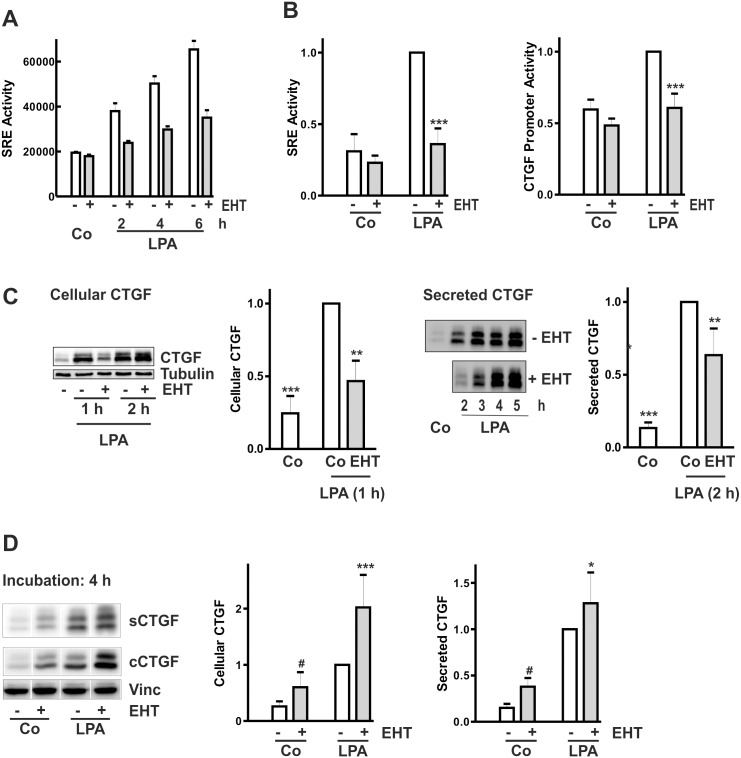
Time-dependent effects of Rac1 inhibition by EHT1864 on CTGF regulation.(A) HKC-8 cells were transfected with SRE promoter constructs. After pre-incubation with EHT1864 (10 μM) for 30 min, the cells were stimulated with LPA (10 μM) for the times indicated. Data are means ± SD from one experiment with triplicate transfections. (B) HKC-8 cells were transfected with SRE or 4.5 kb CTGF promoter constructs. Relative luciferase activity was determined in control cells and cells pre-treated with EHT1864 (10 μM) for 30 min and then stimulated with LPA (10 μM) for 3–4 h. Data are means ± SD of 7 (SRE) and 3 (CTGF promoter) experiments. Activity in LPA-stimulated cells was set to 1 in each experiment. *** p<0.001, compared to cells stimulated with LPA, ANOVA with Dunnett’s multiple comparison test. (C) HKC-8 cells were pre-incubated with EHT1864 (10 μM) for 30 min and then stimulated with LPA (10 μM) for the times indicated. Cellular CTGF was determined in preparations of cellular homogenates by Western blotting. Tubulin was used to control for equal blotting and detection. The graph summarizes data of n = 3 experiments, stimulated with LPA for 1 h (CTGF/tubulin, means ± SD). Secreted CTGF was determined in precipitates of cell culture supernatants by Western blotting. The graph summarizes data of n = 4 experiments, stimulated with LPA for 2 h. Data were normalized to LPA-stimulated CTGF synthesis. *** p<0.001, ** p<0.01, ANOVA with Tukey’s multiple comparison test. (D) HKC-8 cells were pre-incubated with EHT1864 (10 μM) for 30 min and then stimulated with LPA (10 μM) for 4 h. Secreted CTGF (sCTGF) was determined in precipitates of cell culture supernatants and cellular CTGF (cCTGF) in cellular homogenates by Western blotting. Vinculin (vinc) served as control. Samples were detected on one blot which had to be rearranged. Data of 4–5 experiments (cellular CTGF, 4 h) and 5–7 experiments (secreted CTGF, 4–6 h) are summarized in the graphs. CTGF expression in LPA-stimulated cells was set to 1 in each experiment. * p<0.05, ***p<0.001 compared to LPA-stimulated cells, ANOVA with Tukey’s multiple comparison test. # p<0.05, paired 2-sided t-test, EHT1864-treated cells compared to control cells.